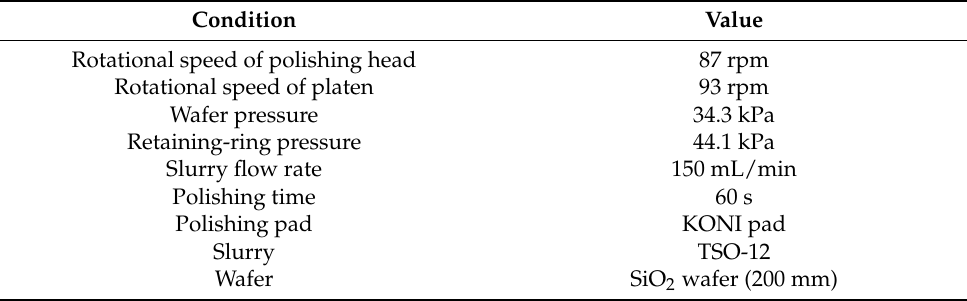
Table 4. CMP experimental